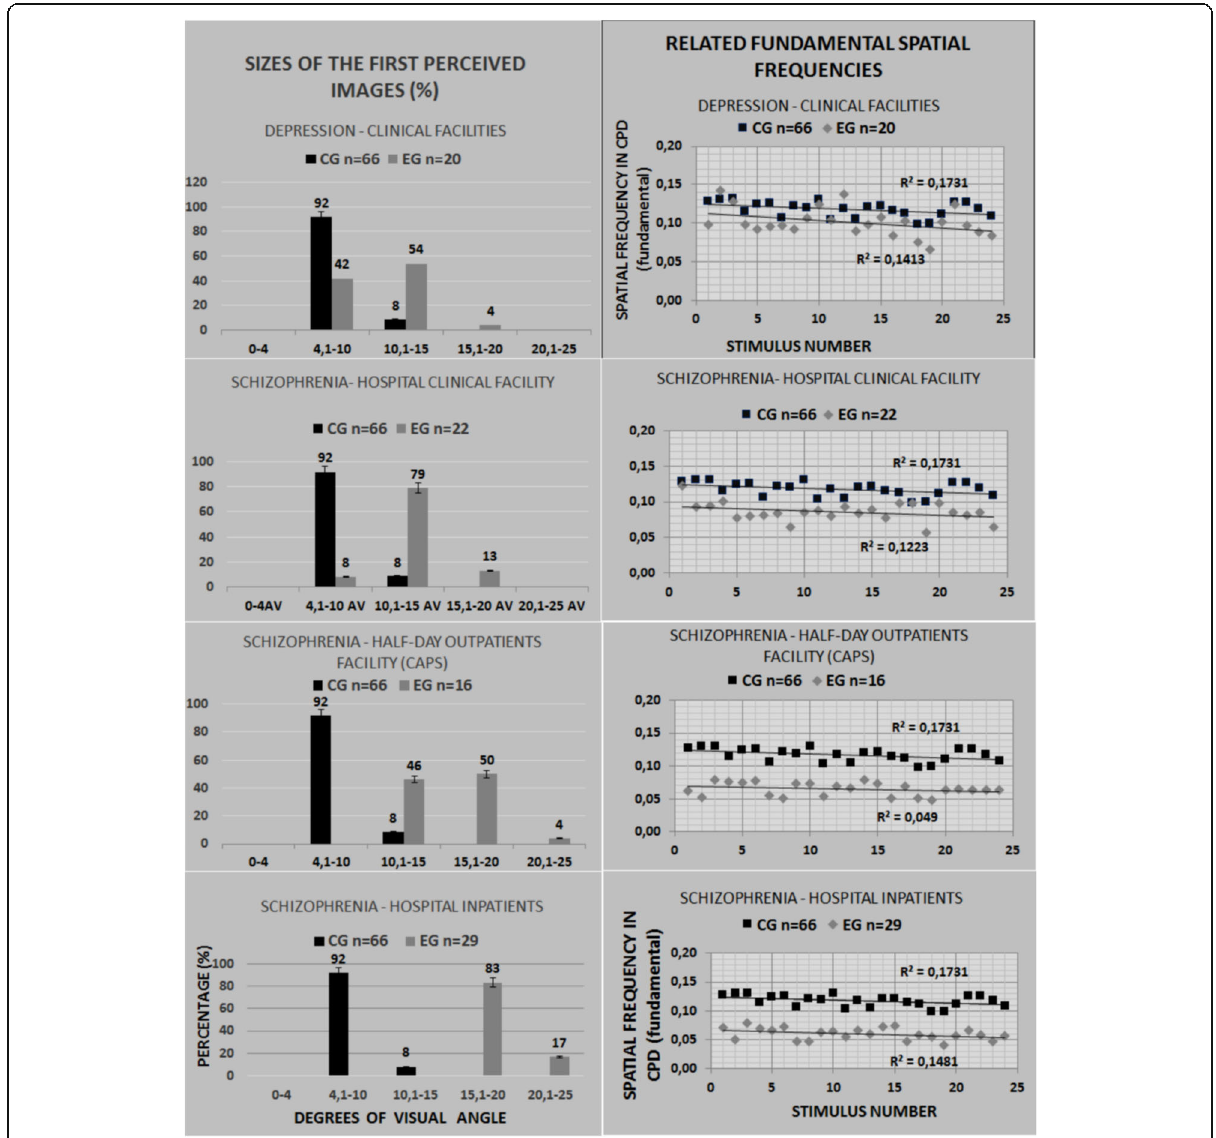
Fig. 5 Sizes of the first perceived images from previous studies (Simas, et al., 2011; Lacerda, Simas, & Menezes, 2020; Modesto, 2012 [unpublished M.A. Thesis]) both in degrees of visual angle (left) and in spatial frequency of the respective fundamentals (right). The control groups of three experiments were treated as a single group ( N =66). Note. Original figure including results adapted from Simas et al. (2011), from Lacerda et